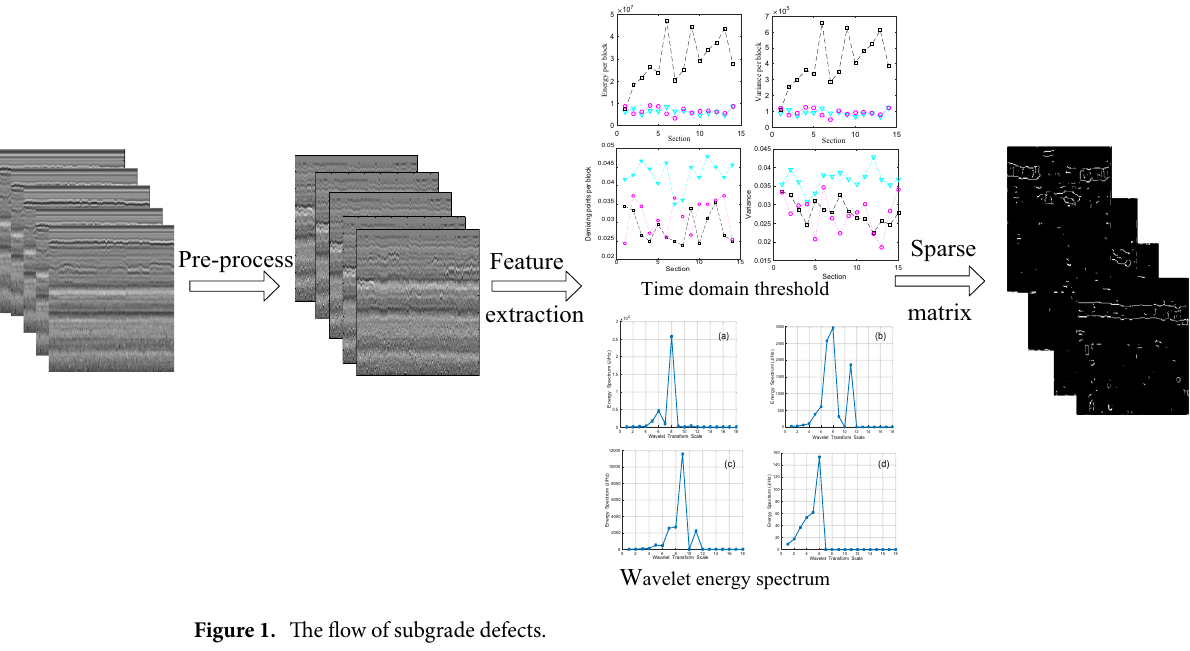
Figure 1. The flow of subgrade defects.